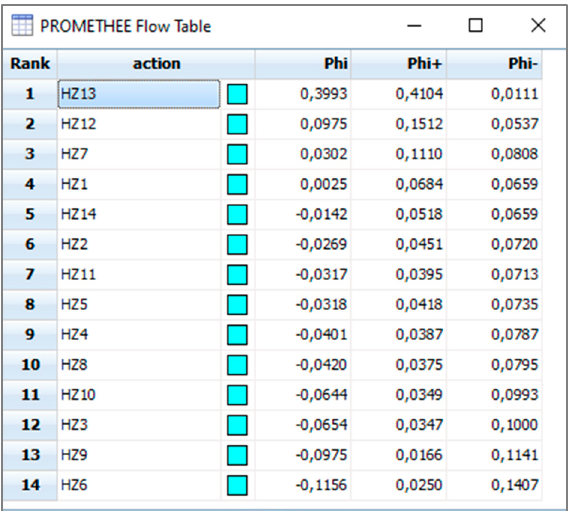
Figure 12. Results of the PROMETHEE method for 14 homogeneous zones (better rank represents higher risk).